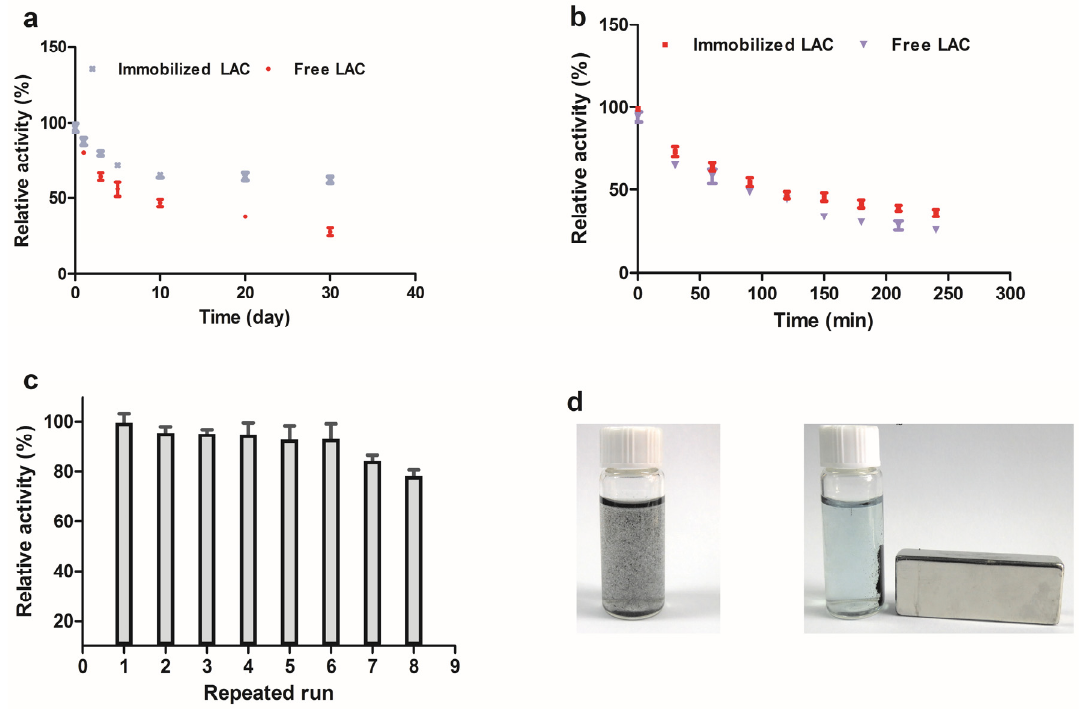
Figure 6. ( a ) Storage stability; ( b ) thermal stability; and ( c ) operational stability of free and immobilized Lac; ( d ) Recovery of immobilized Lac from the solution using a magnet.